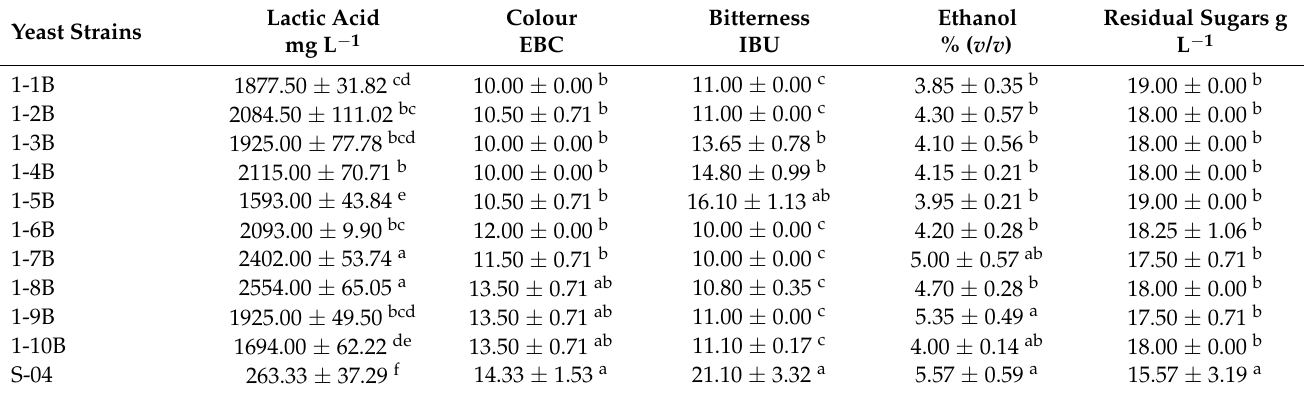
Table 1. Results of the parameters analysed on the 100 mL scale for the L. thermotolerans yeast strains